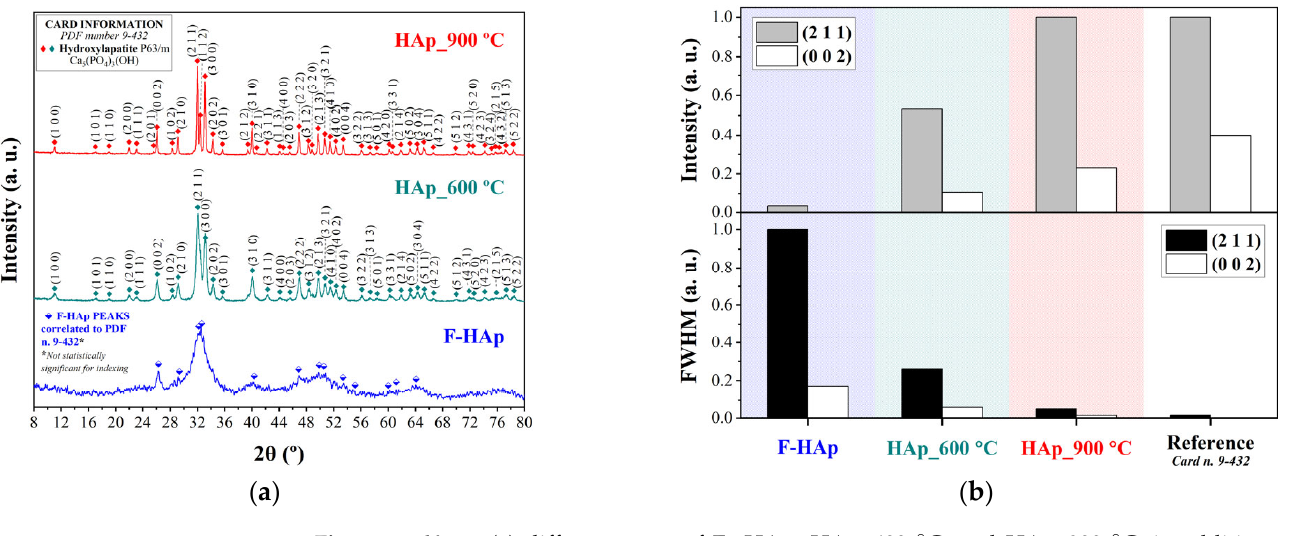
Figure 1. X - ray ( a ) diffractograms of F − HAp, HAp_600 °C, and HAp_900 °C, in addition to ( b ) Figure 1. X-ray ( a ) diffractograms of F − HAp, HAp_600 ◦ C, and HAp_900 ◦ C, in addition to FWHM and intensity plots for peaks (2 1 1) and (0 0 2). ( b ) FWHM and intensity plots for peaks (2 1 1) and (0 0 2). Table 2. Calculated Unit Cell lattice parameters (hexagonal